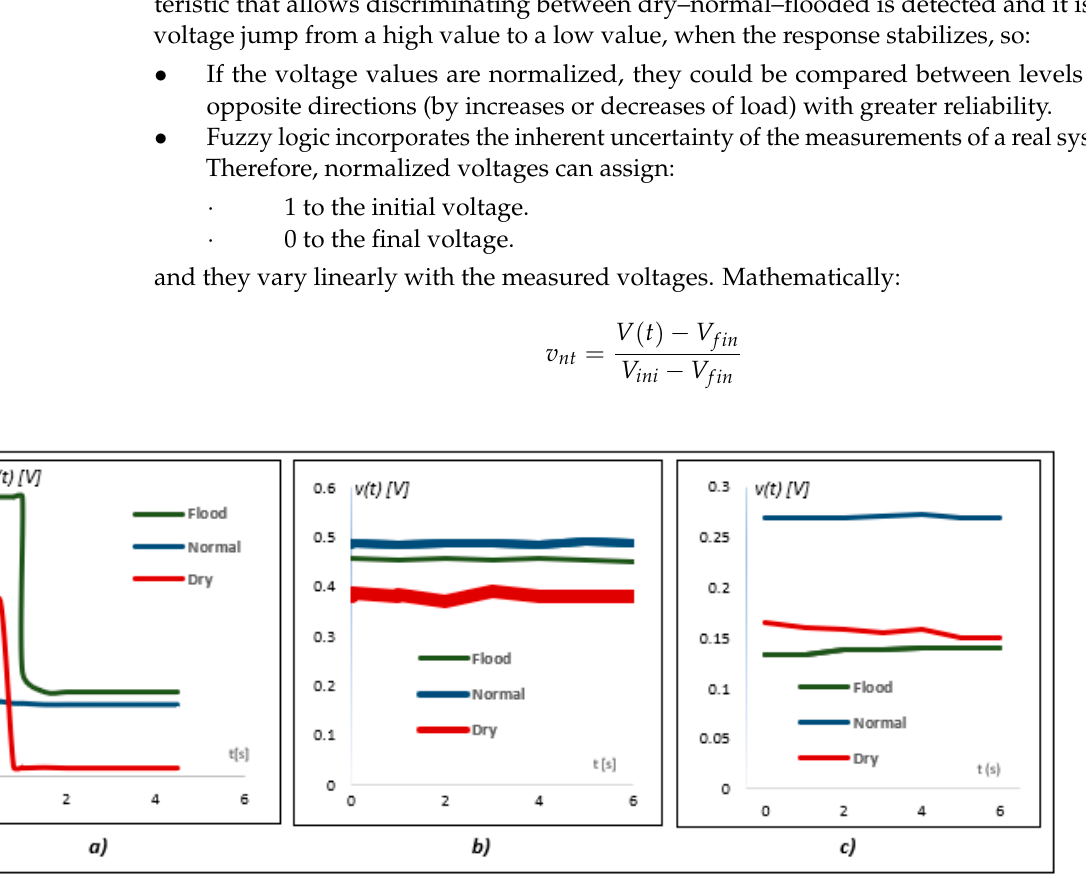
Figure 2. Temporal evolution of the PEMFC voltage for the three humidification degrees and under different disturbances. ( a ) Load step. ( b ) Current oscillations. ( c ) Flow step.